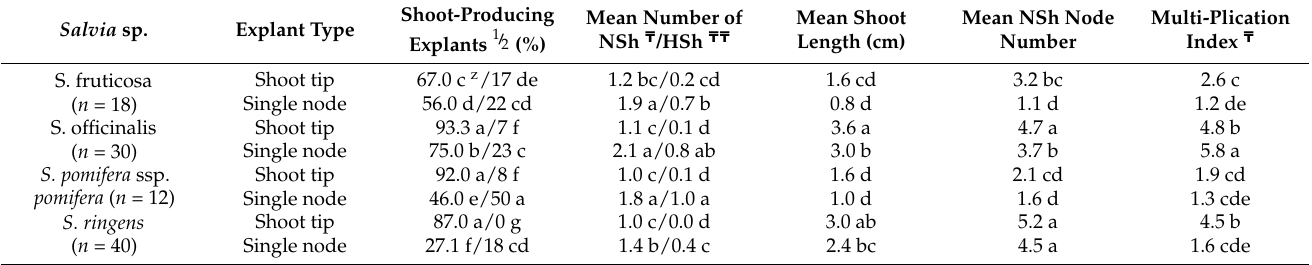
Table 1. Effect of Salvia species and explant type on axillary shoot production of explants excised from in vitro seedlings of Greek sage species, at the establishment stage of in vitro cultures on a hormone-free MS medium.